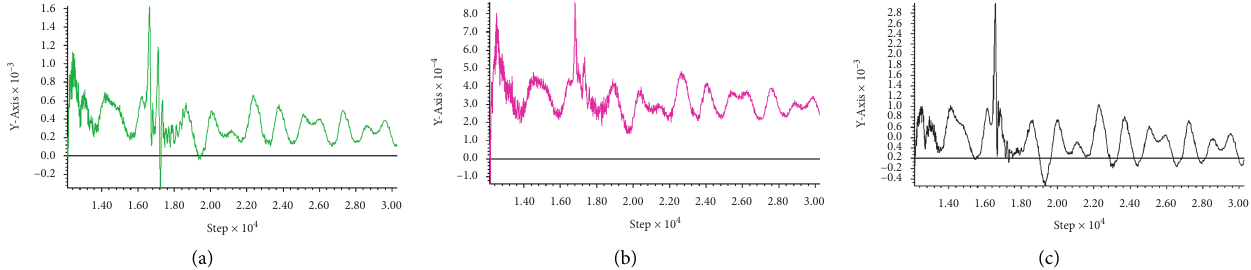
Figure 18: The vibration speed changes when first excavated roadway with bolt support: (a) roof, (b) left side, and (c) right side.